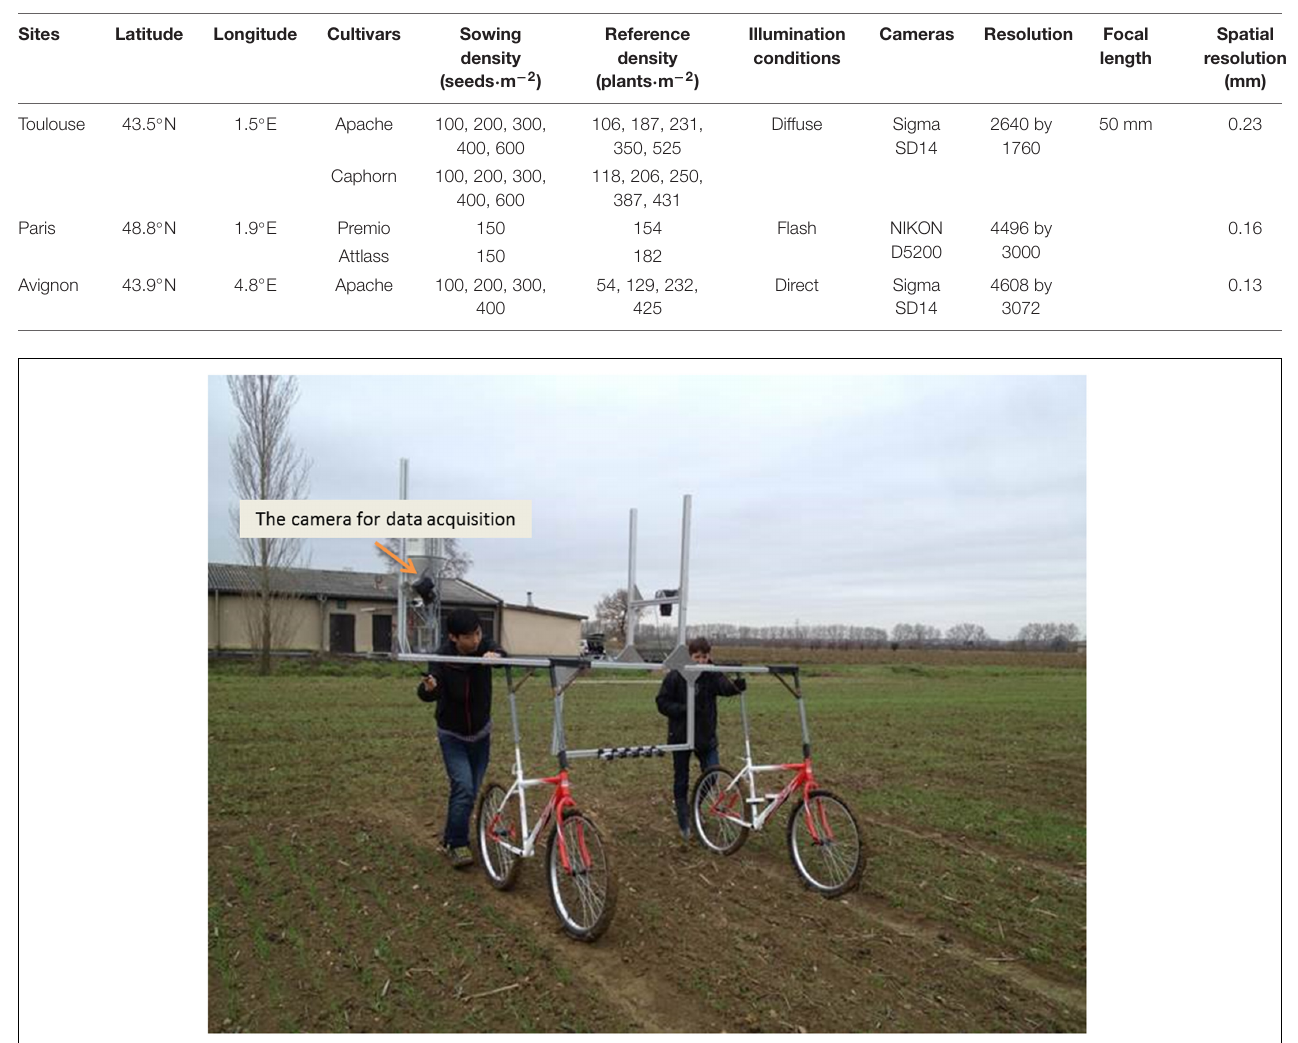
FIGURE 1 | The image acquisition in the field with the Phenotypette.